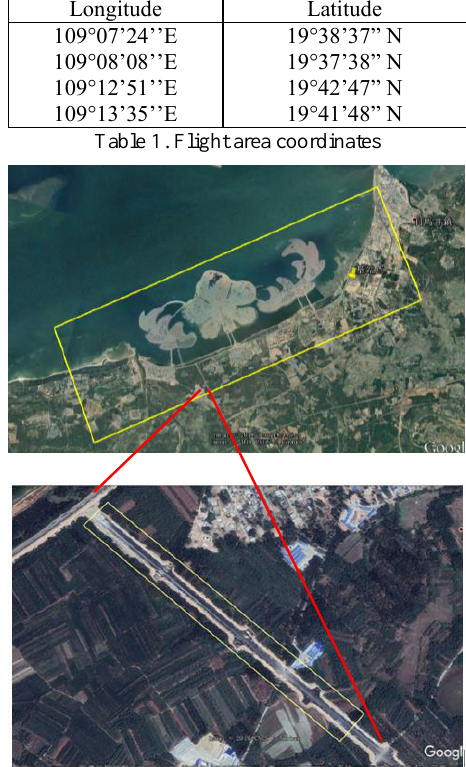
Table 1. Flight area coordinates